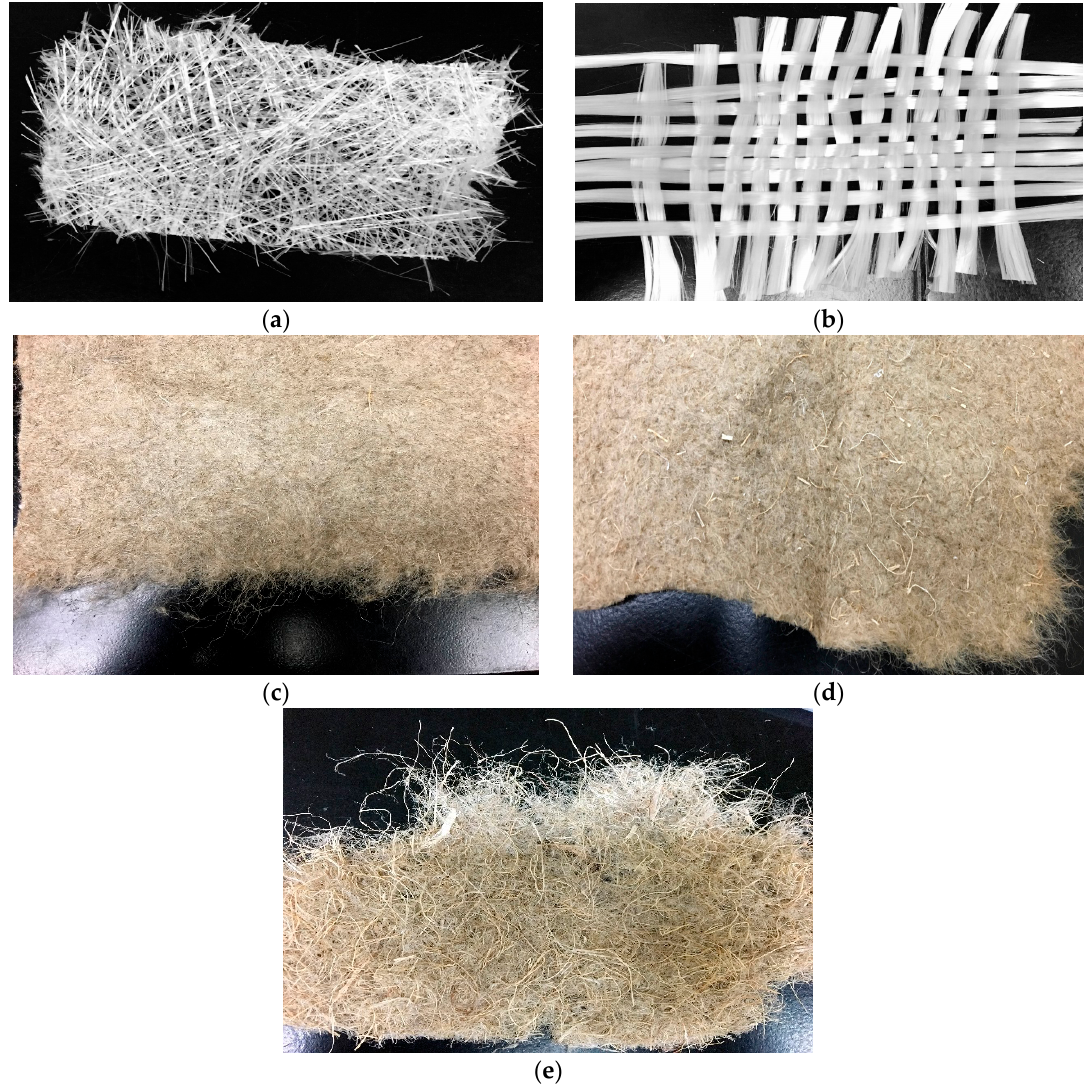
Figure 1. Different fiber mats used in the study. ( a ) non-woven glass mat; ( b ) woven glass mat; ( c ) flax1; ( d ) flax2; ( e ) hemp-agave.